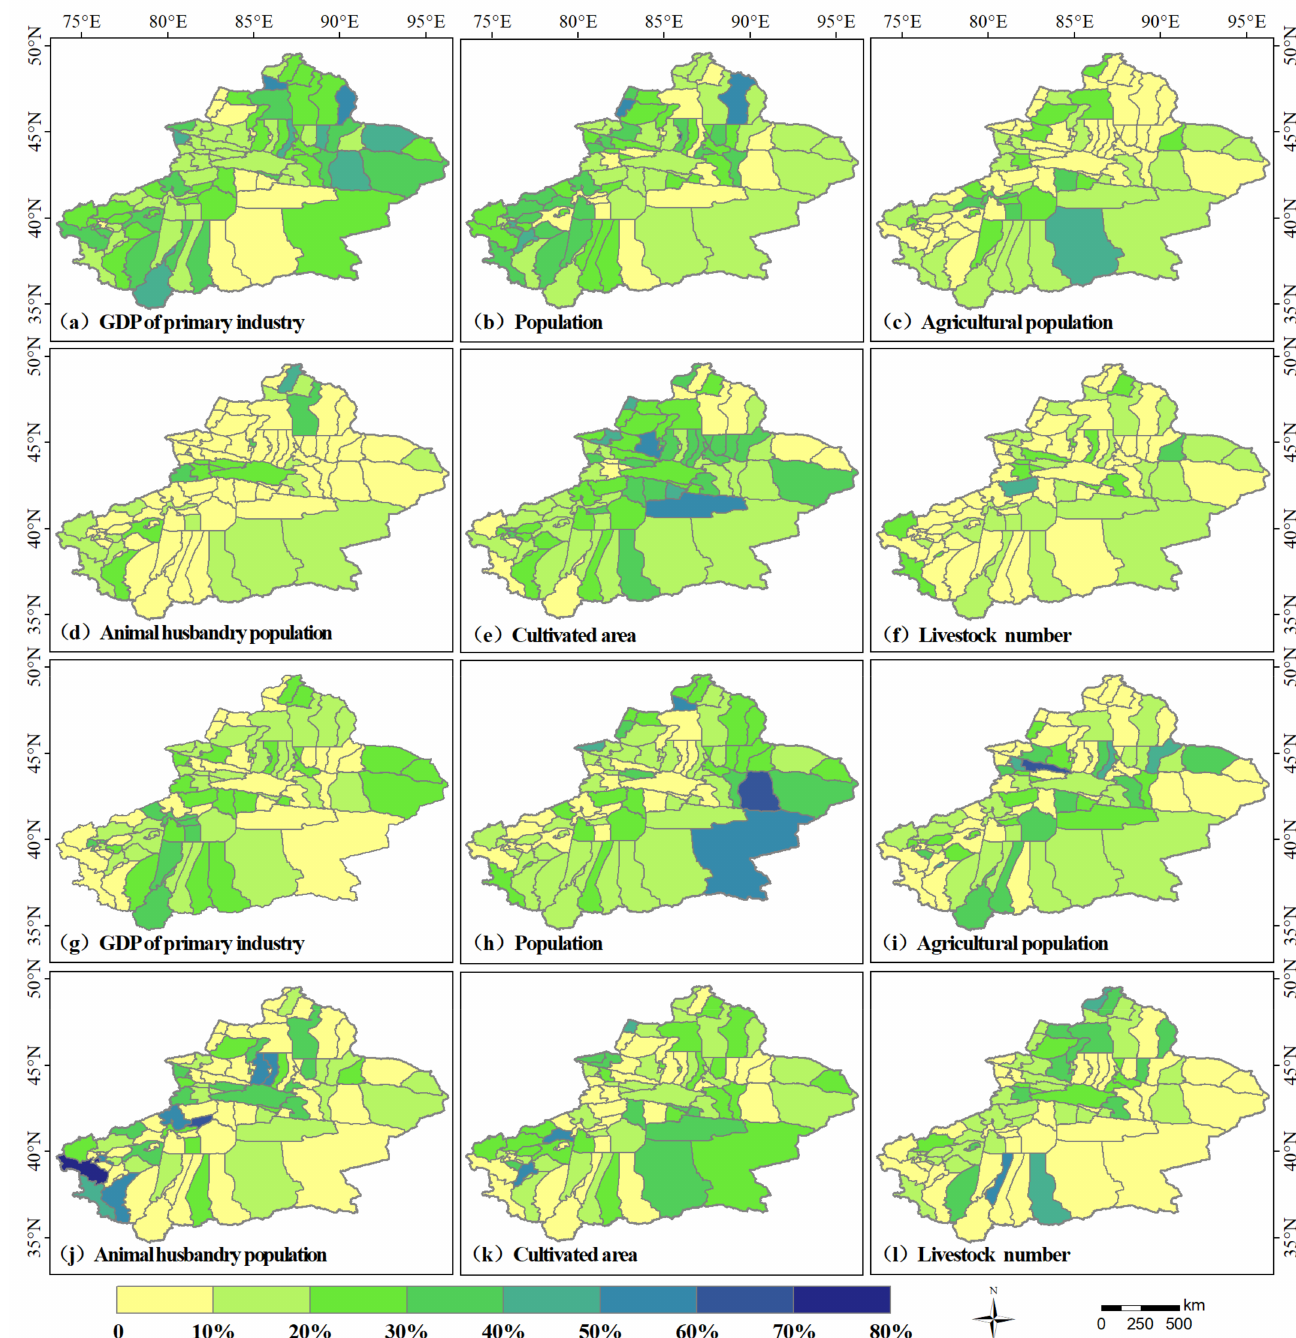
Figure 9. The relative contribution of human activities for the increase ( a – f ) and decrease ( g – l ) of NDVI for each county in